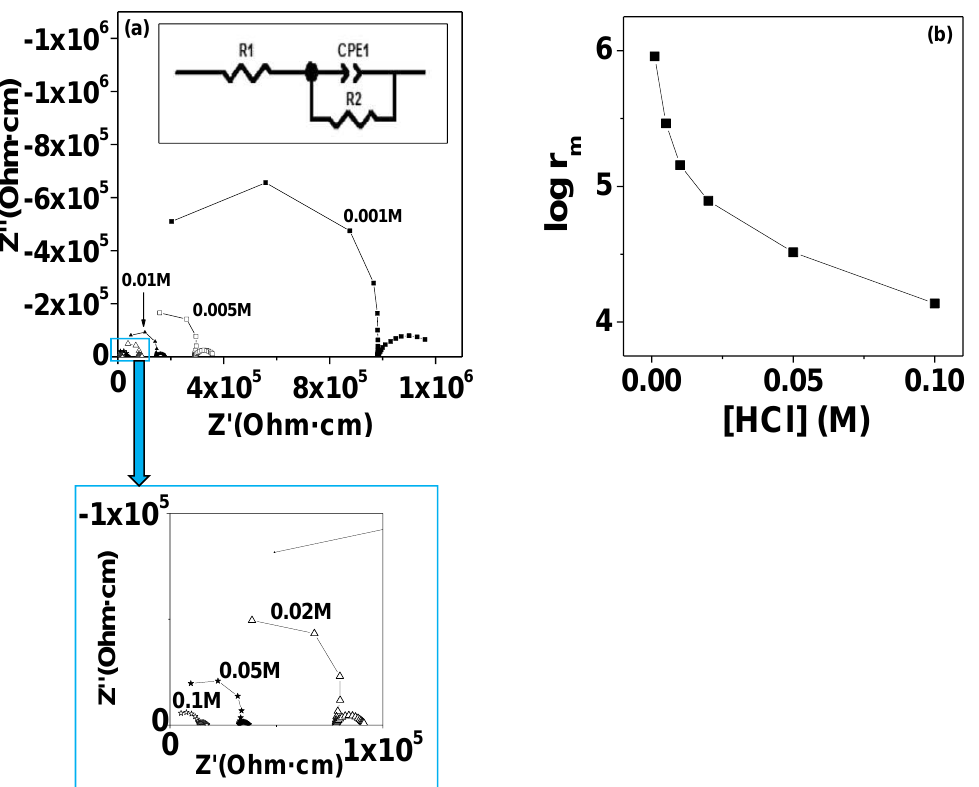
Figure 8. ( a ) Complex impedance plots of sPSU/10% TiO 2 (B) composite at different HCl concentra- tions. In the inset, the equivalent circuit used for the data fitting is also displayed and ( b ) the ionic resistivity evolution for different HCl solutions.